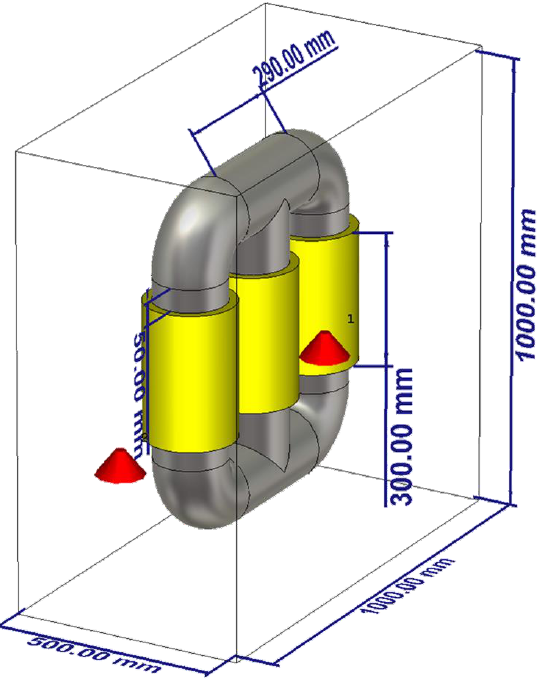
Figure 10. The geometry of the transformer tank including transformer windings and metallic core. Table 3. Location of the considered sensor and PD source inside the transformer tank, including the transformer winding and metallic core.